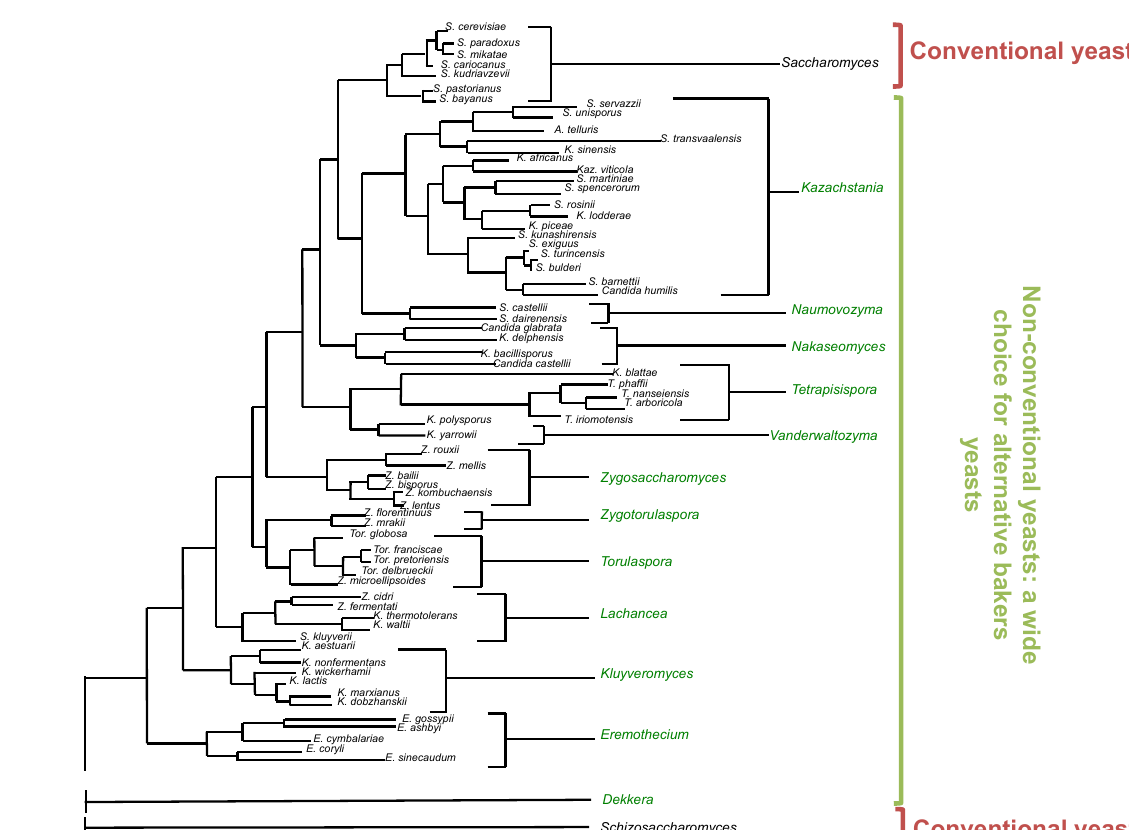
Figure 1. Phylogenetic position of non-conventional yeasts. This figure was adapted from [6]. The figure shows 12 clades resolved by a concatenation of gene sequences reported [40]. Non-conventional yeasts and their attributes of importance as alternative baker’s yeasts are highlighted in green, whereas the conventional yeasts are highlighted in red.